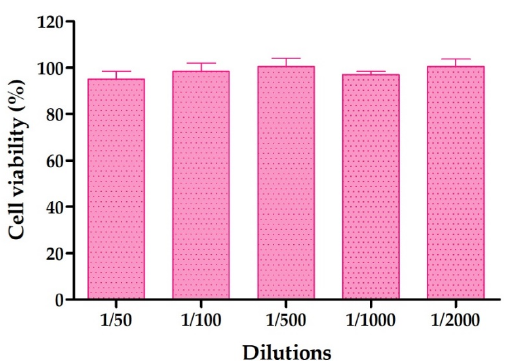
Figure 5. Percentage of cell viability of HaCaT cell line exposed to AmB+BGEO for 24 h at different concentrations.